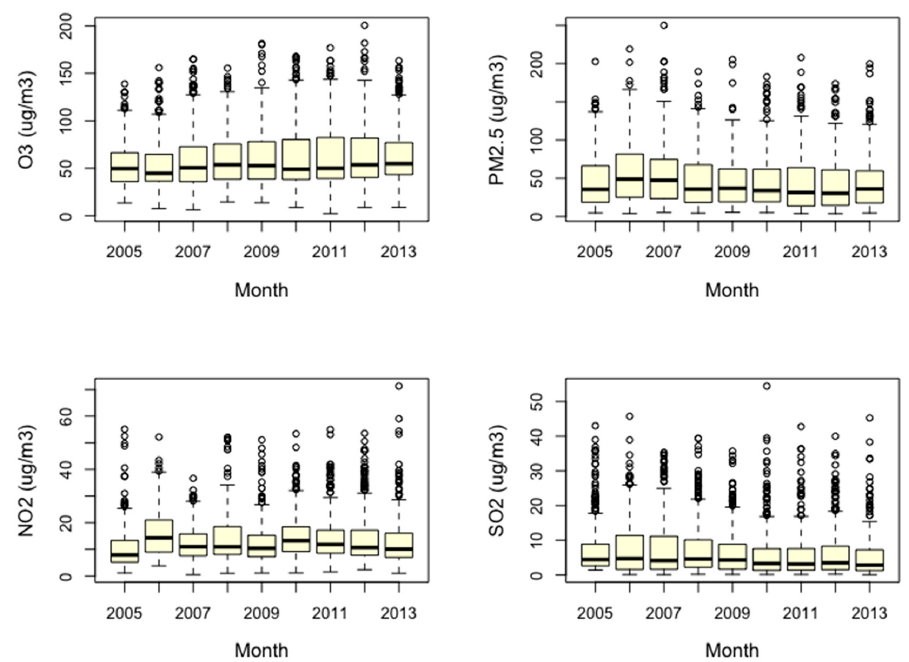
Figure 3. Box plots of air pollutants during the study